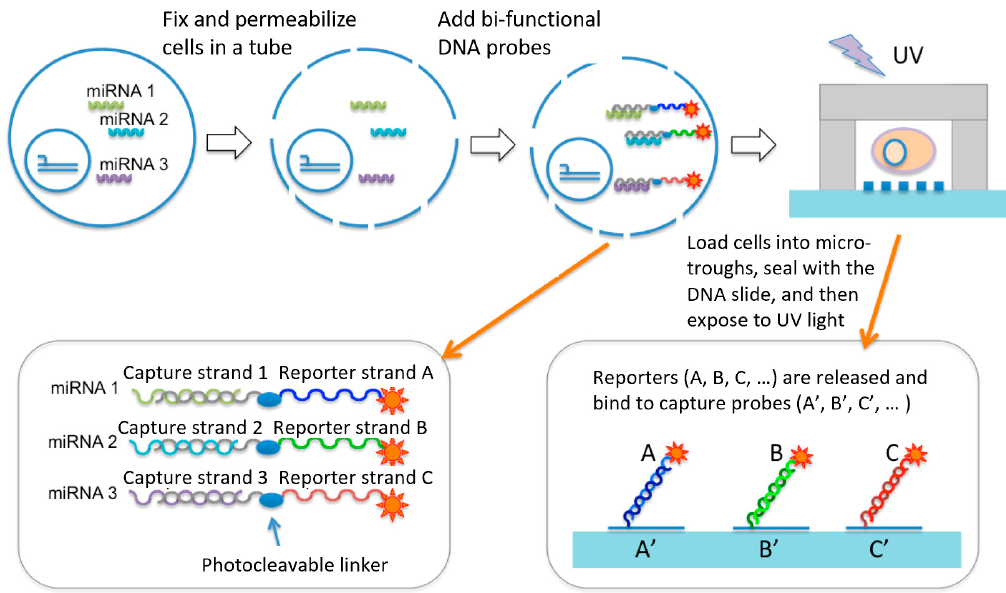
Figure 1. Design of overall workflow. It employs a unique set UV cleavable miRNA capture/reporter probes and combines with a microtrough array chip for single-cell microRNA measurement. This UV cleavable probe contains a photocleavable (PC) covalently linked with two DNA oligomer strands. One is complementary with the miRNA targets and the other is complementary with the DNA barcode probes immobilized on the surface of a poly-L-lysine (PLL)-coaed glass slide.